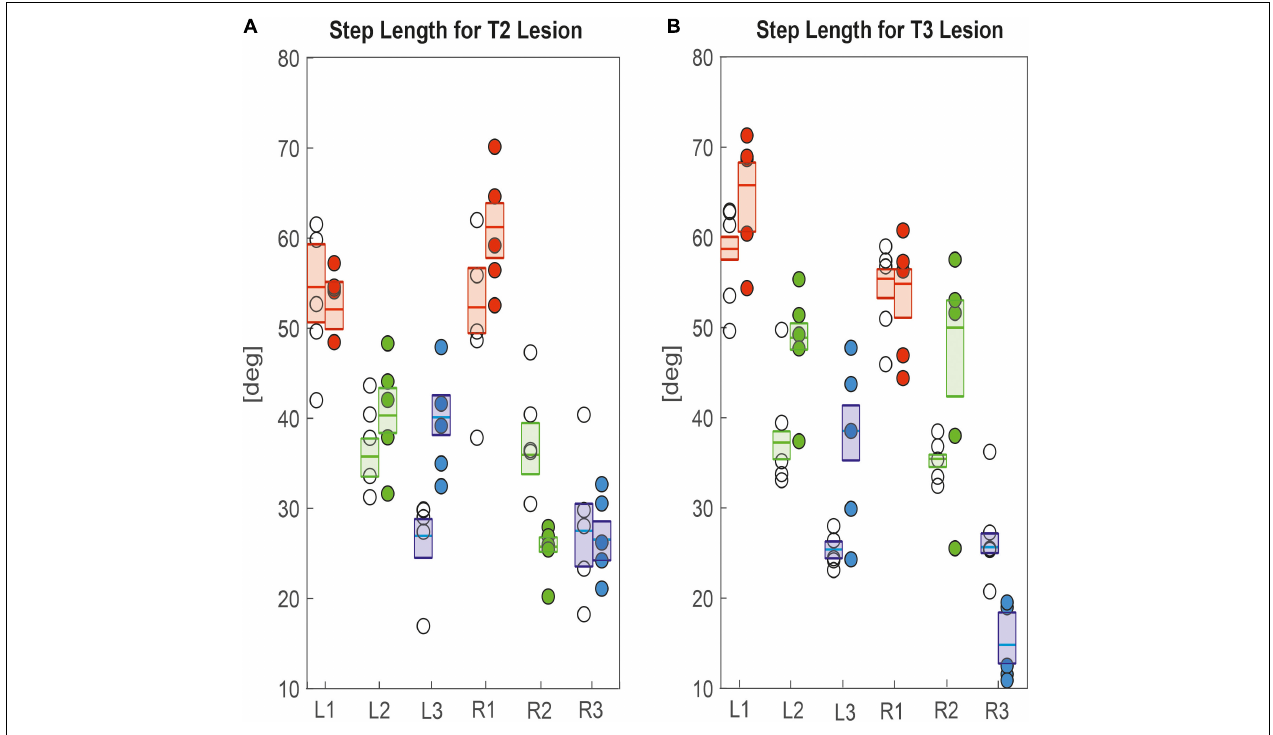
FIGURE 6 | Effects on step length. (A) Pro-to-mesothorax connective; (B) meso-to-metathorax connective. Symbols show median step length per animal with connective lesion (filled circles) or sham operation (open circles). Boxes comprise all trials of the cohort and show the median step length and the bootstrapped 95%